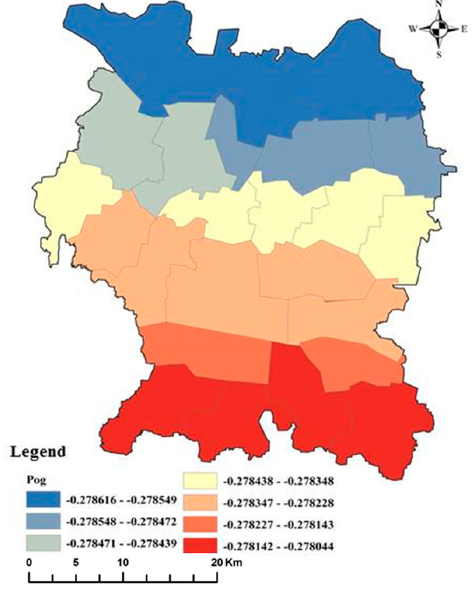
ffi cient of Figure 8. Regression coefficient of Pog. Figure 8. Regression coe Figure 8. Regression coefficient of Pog.